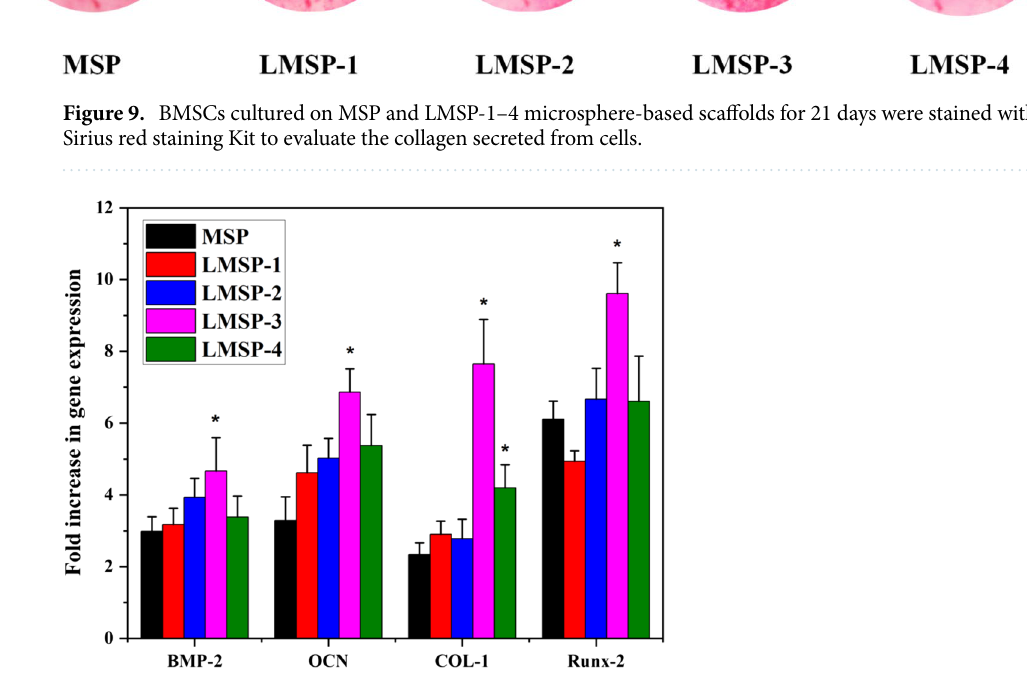
Figure 10. Evaluation of the osteogenic expression of BMSCs seeded and cultured on microsphere-based scaffolds for 21 days via gene expressions of BMP-2, OCN, COL-I, and Runx-2. (*) means the difference was statistically significant (p < 0.05) when made a comparison to the MSP